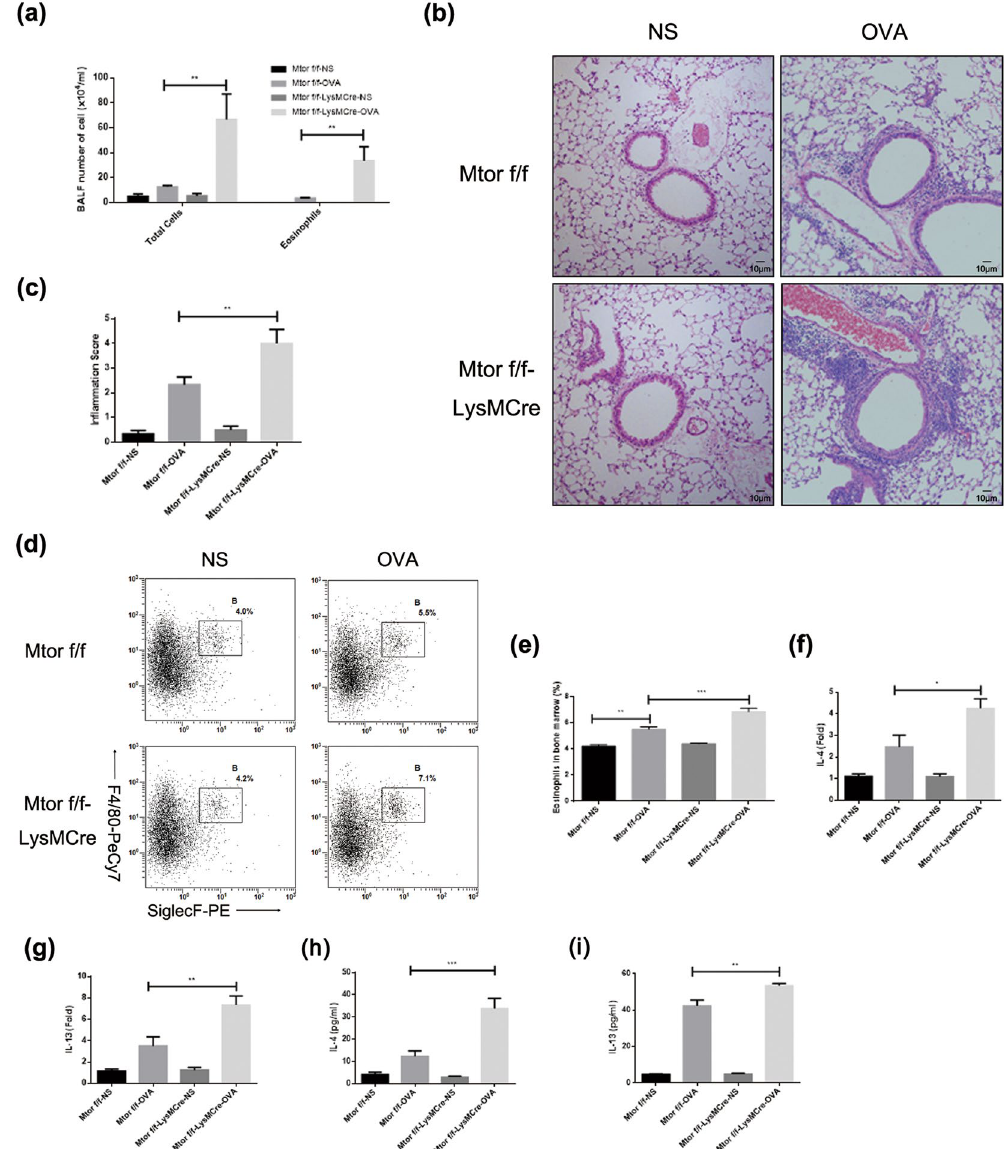
Figure 6. Myeloid knockout of mTOR deteriorates OVA-induced allergic airway inflammation. ( a ) Two strains of mice received ovalbumin (OVA) mixed with an injection of alum adjuvant on day 0 and day 14 for sensitization, then challenged with 1.5% OVA by nebulization. 24 hours after the last OVA exposure, mice were anaesthetized and sacrificed. Bronchoalveolar lavage fluids (BALFs) were obtained and total cells and eosinophils in BALFs were counted. ( b , c ) Representative histological images are shown (b) Inflammation scores were calculated according to H&E slides. ( d and e ) Bone marrow cells were also harvested and red blood cell lysis was performed. Eosinophil percentage was detected (d) and statistically analysed ( e ). ( f – i ) Th2 cytokines were detected by lung homogenates. F, mRNA expression of IL-4. G, mRNA expression of IL-13. H, protein concentration of IL-4. I, protein concentration of IL-13. Results were analysed as means ± SEM. All the results above were repeated by three independent experiments (n = 8 per group). * P < 0.05, ** P < 0.01, *** P <